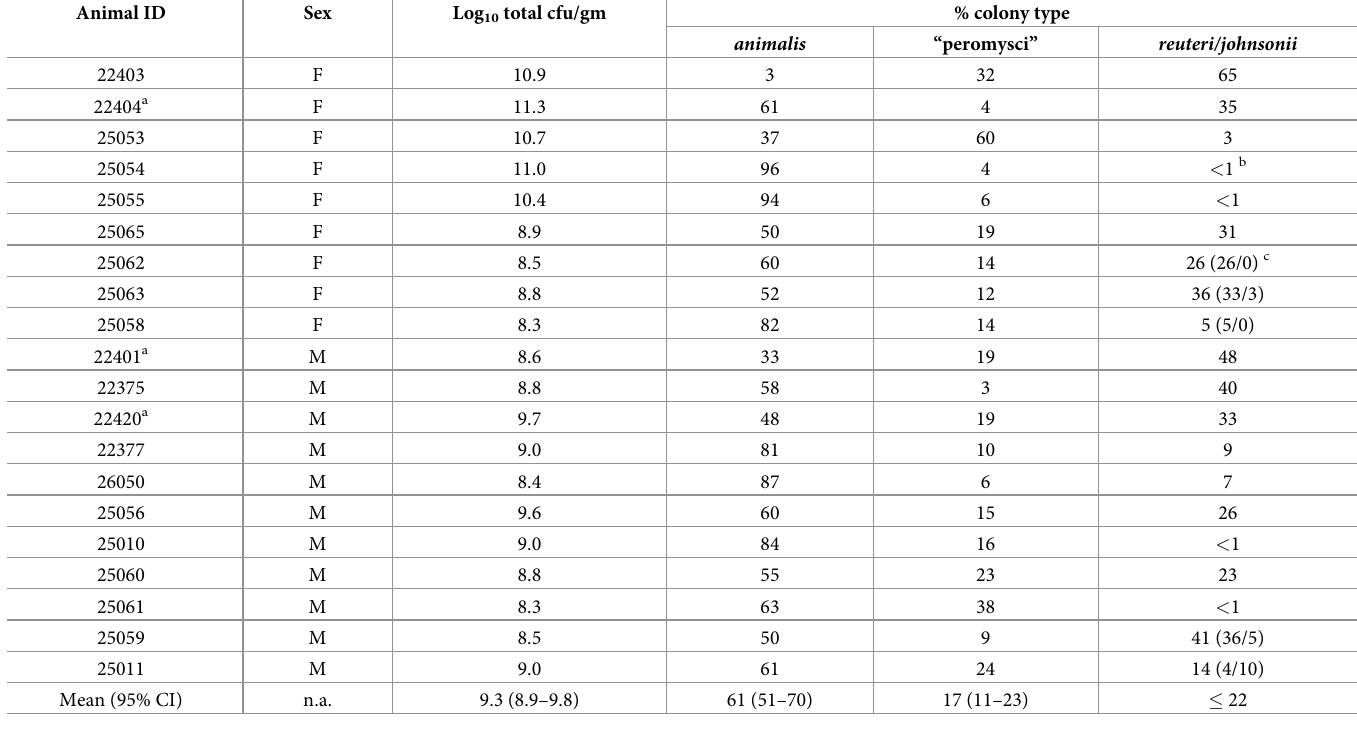
Table 3. Colony forming units (cfu) of Lactobacillus spp. in Peromyscus leucopus stomach. Animal ID